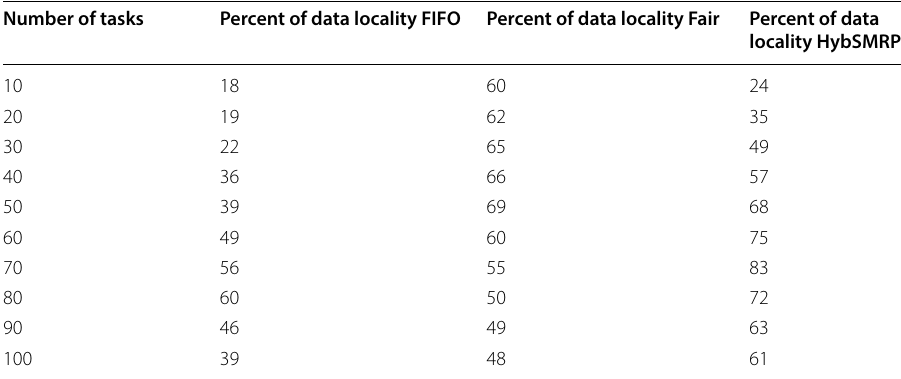
Table 4 Numerical comparison of HybSMRP with FIFO and Fair schedulers based on data locality rate on Wordcount Number of tasks